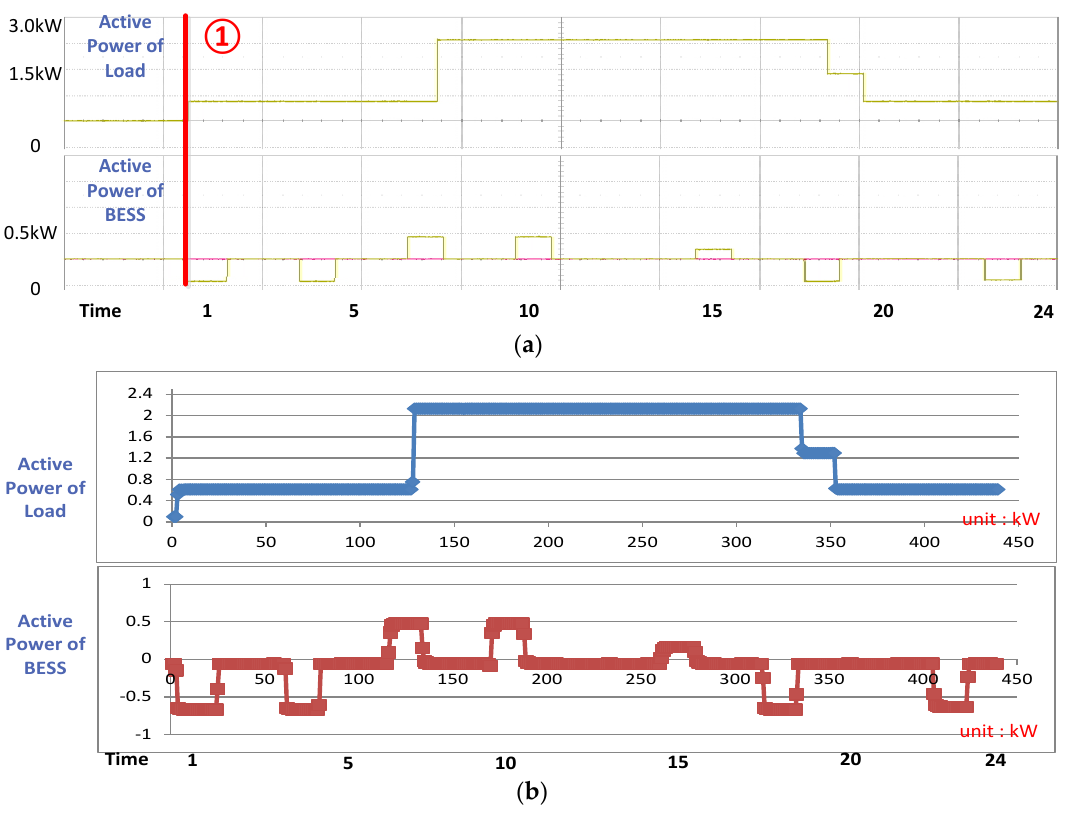
Figure 15. Hardware test result compared to the HILS test result of scenario 1 ( a ) Measurement at the oscilloscope installed in front of each piece of hardware; ( b ) Data stored in a new distribution simulator.